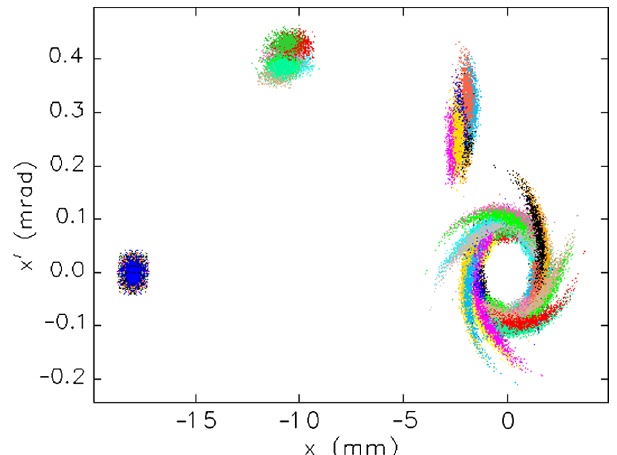
FIG. 24. Phase space coordinate of the matched injected beam during ten turns passing through the low field ring. Errors of the injection kickers have been included. Colors indicate the number of turns for different